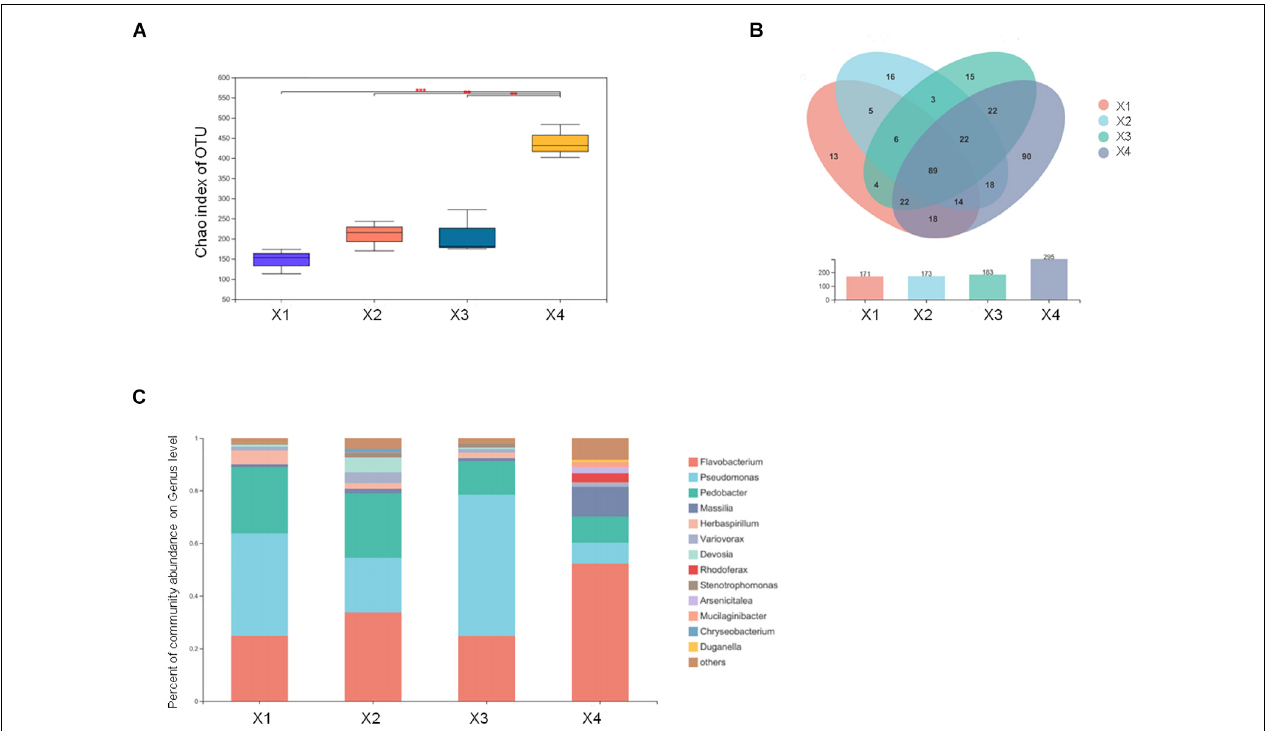
FIGURE 5 | Different microbial communities in the fruiting body development stages. (A) The Chao index of operational taxonomic unit (OTU) levels. (B) Venn plot shows the number of detected OTUs of the fruiting body. (C) The endophytic microbial community analysis with development stages of the fruiting